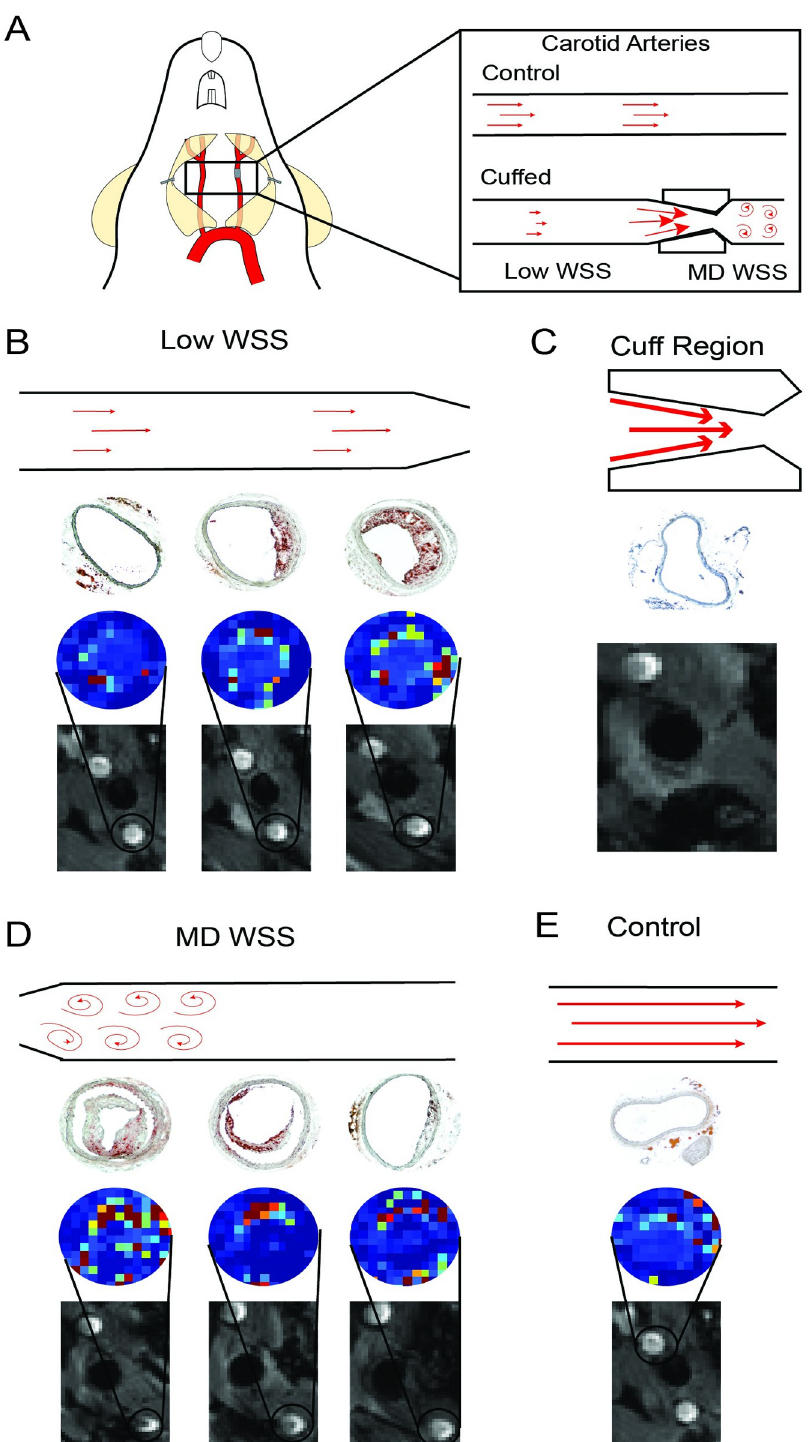
Fig 1. Representative sequence of co-registered MR images and histological data along the length of the instrumented carotid artery. (A) Diagram of the flow environment in the instrumented versus contralateral control carotid arteries. The cuff creates three distinct hemodynamic conditions, low WSS upstream of the cuff, high WSS within the cuff, and multidirectional (MD) WSS downstream of the cuff [11]. (B-D) Longitudinal sequence of DCE-MR images and K trans maps co-registered to histology sections stained with oil red O to identify lipid from the